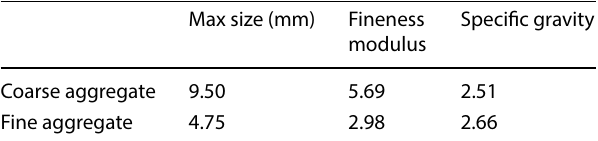
Table 2 Properties of aggregates